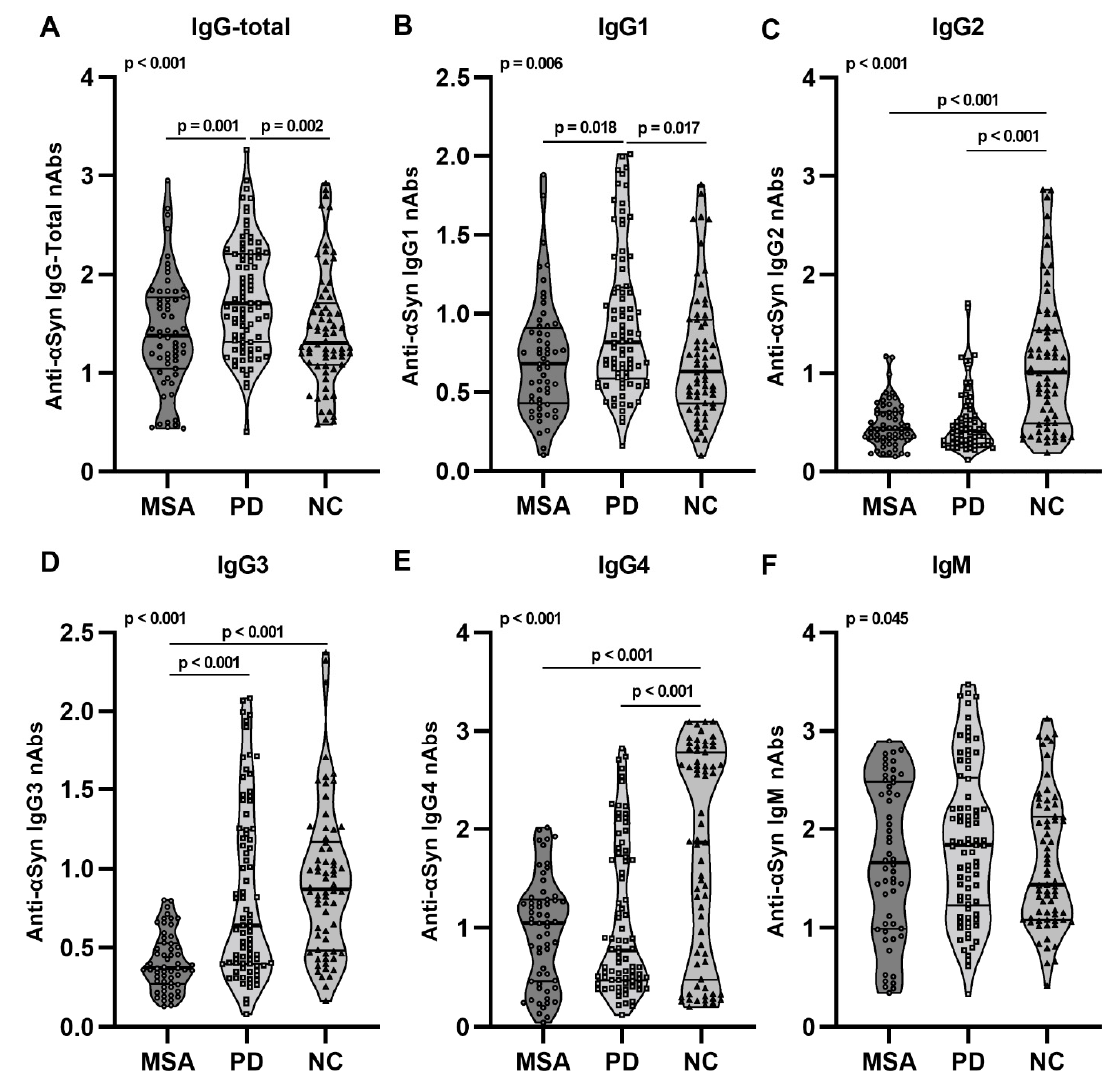
Figure 2. Serum anti- α Syn IgG-total, IgG subclasses, and IgM nAbs. The graphs represent relative levels of anti- α Syn ( A ); IgG-total and IgG1–4 ( B – E ); and IgM ( F ) nAbs in individual pMSA ( n = 59), pPD ( n = 82) and control ( n = 67) serum samples. Data are presented as relative optical densities normalized to standard curve using anti- α Syn monoclonal antibody. Differences between groups were tested using multiple linear regression modeling including age and sex as confounding variables. Graphs are presented as truncated violin plots with median ( bold lines ) and 25% quantiles ( thin lines ).